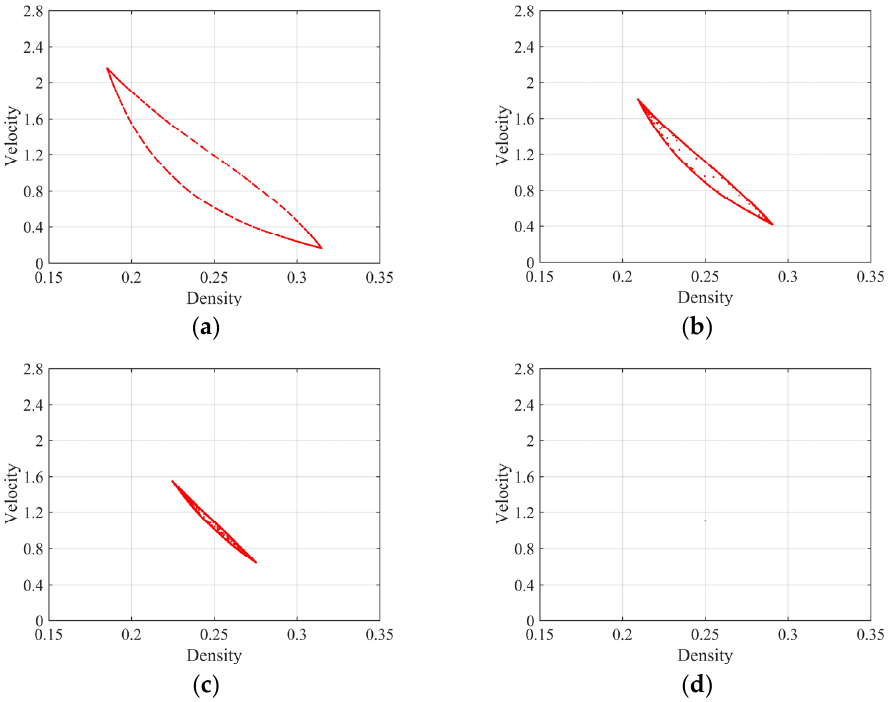
Figure 9. The hysteresis loops of velocity and density for different k . ( a ) k = 0, ( b ) k = 0.1,